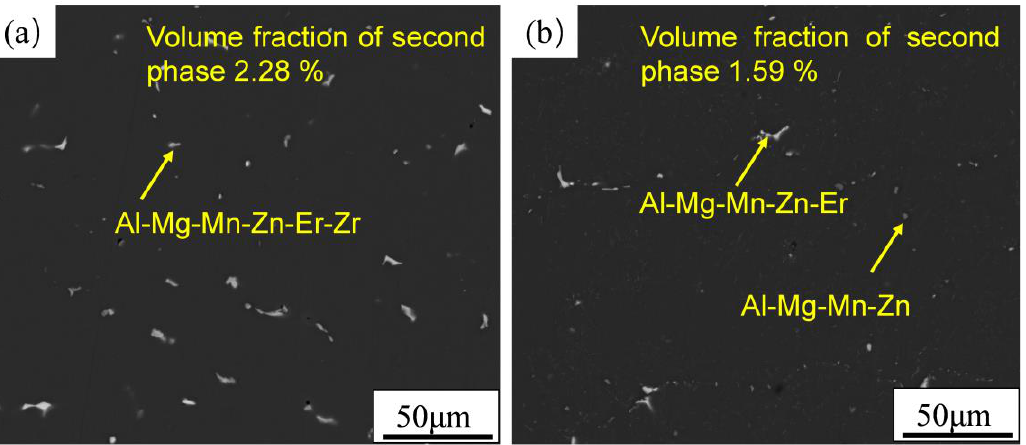
Figure 1. The backscattered electron images: ( a ) as-cast microstructure; ( b ) microstructure after ho- mogenization.